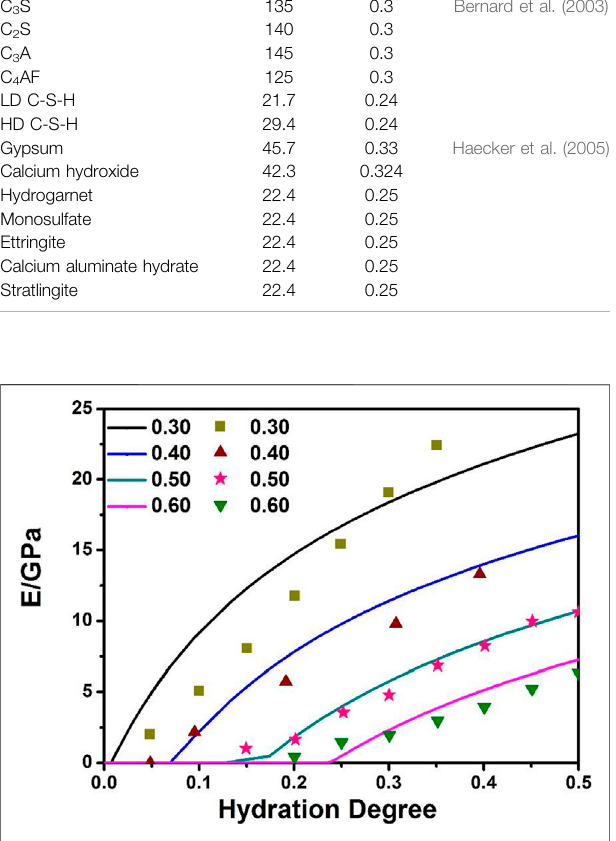
FIGURE 3 | Elastic modulus ( E ) predicted using our model (continuous lines) and experimental results (points) for different w/c ratios.